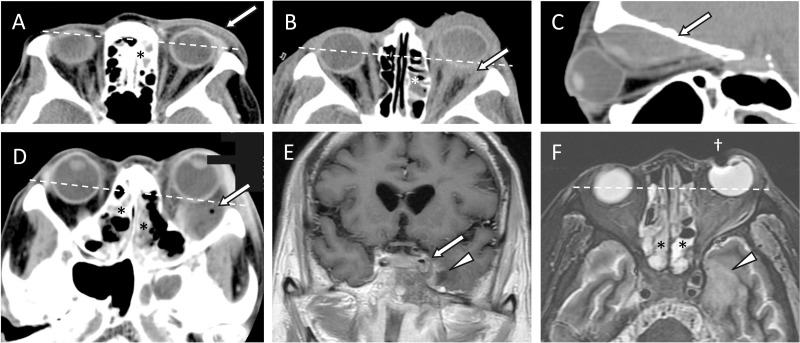
Characteristic findings of each stage of sinusitis-related orbital complications determined via computed tomography (CT) or magnetic resonance imaging (MRI).(A) Stage I, preseptal cellulitis (arrow) on an axial CT image. (B) Stage II, orbital cellulitis (arrow) on an axial CT image. (C) Stage III, subperiosteal abscess (arrow) on a sagittal CT image. (D) Stage IV, orbital abscess (arrow) with a tiny air bubble on an axial CT image. (E and F) Stage V, cavernous sinus thrombosis (arrow) on a coronal contrast-enhanced T1-weighted MRI, and focal cerebritis (arrowheads) on a coronal contrast-enhanced T1-weighted MRI and an axial T2-weighted MRI. * Ethmoidal sinusitis. † Artifact due to metal material. Dashed lines: Proptosis in one eye compared with the fellow eye.